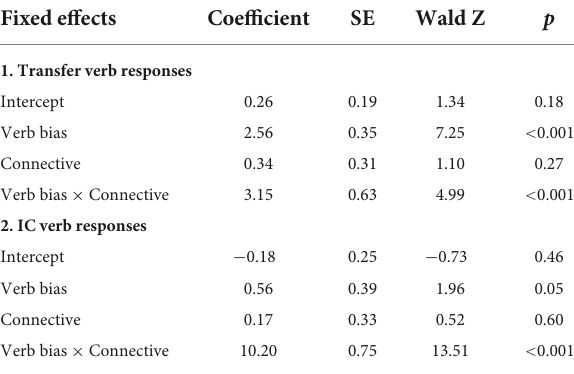
TABLE 1 Summary of logit mixed effect models for referent